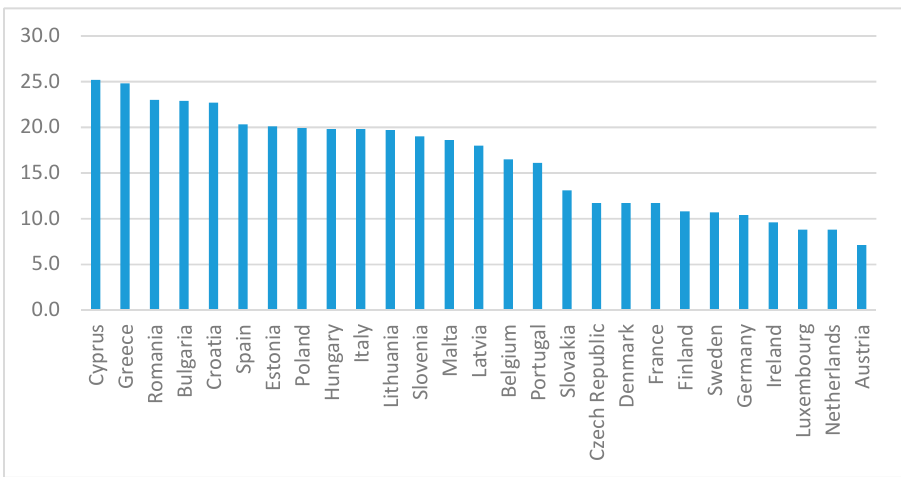
Figure 2. Shadow economy (% of GDP) in European Union countries, 2017. Source: Authors’ procedure based on Medina and Schneider (2019).